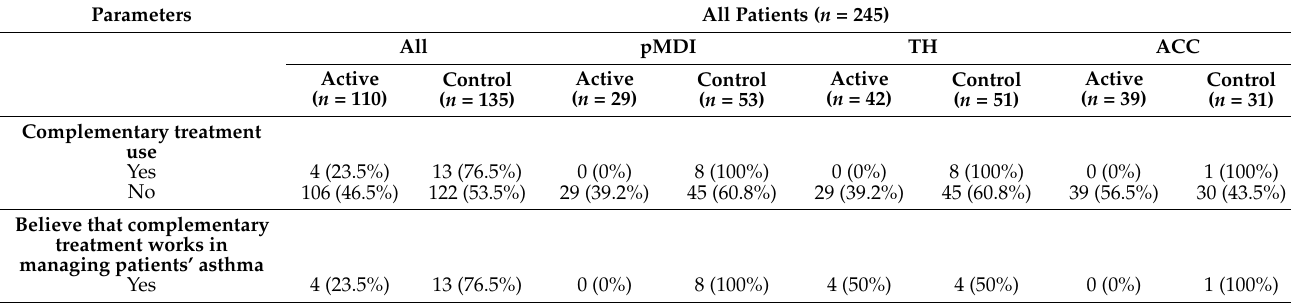
Table 3. Complementary treatment information for the different study inhaler groups ( n = 245).